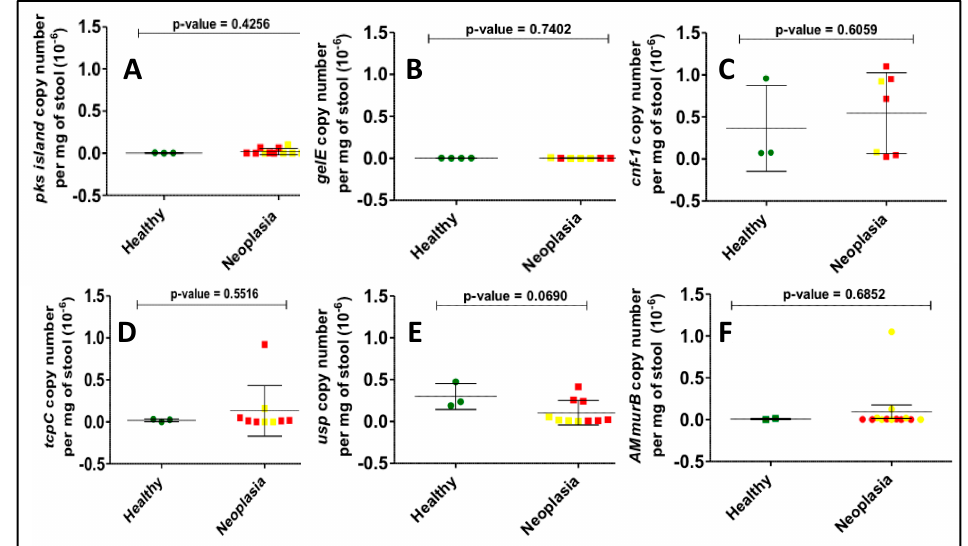
Figure 3. Determination of gene copy number per mg of stool for all positives among the US samples by real-time quantitative PCR. Here we show the results for ( A ) pks island , ( B ) gelE , ( C ) cnf-1 , ( D ) tcpC , ( E ) usp , ( F ) AMmurB showing no statistical differences between the healthy (green dots) and neoplasia groups, which include adenomas (yellow dots) and CRC (red dots) individuals.